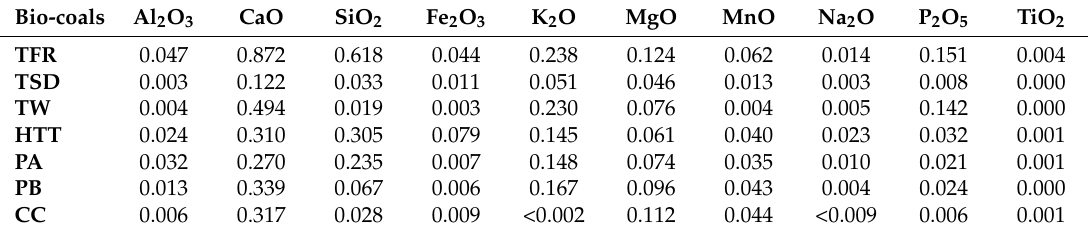
Table 3. Metal oxides in bio-coals (Wt %, dry